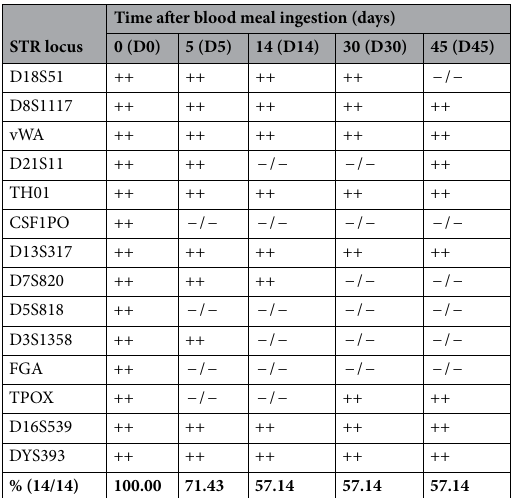
Table 1. Human STR analysis of blood cellular DNA drawn from the tropical bed bugs. (++) both alleles of heterozygous or homozygous loci were readable. (+/−) only one allele of heterozygous or homozygous loci was readable. (−/−) both alleles were not detectable. (%) percentage of profile completeness. Significant values are in bold